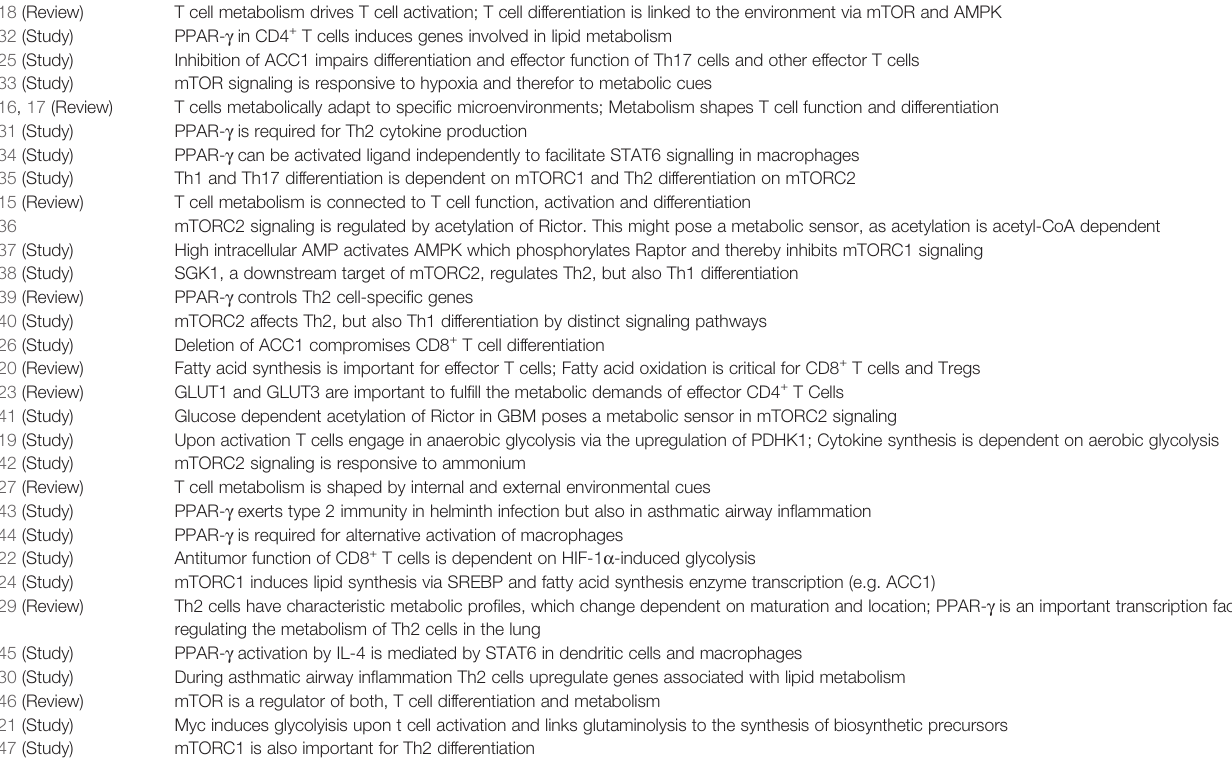
TABLE 1 | Studies investigating the metabolism of Th2